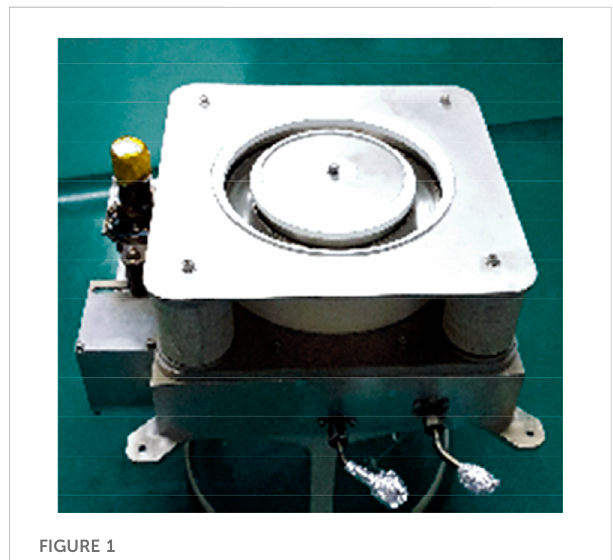
FIGURE 1 LHT-140 hall thruster.